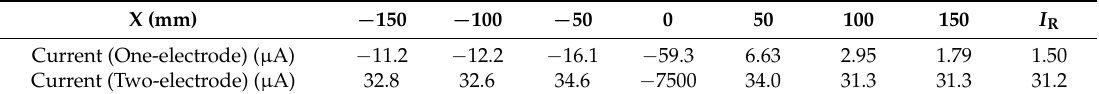
Table 2. Current through the cross-sections and the receiver resistor.